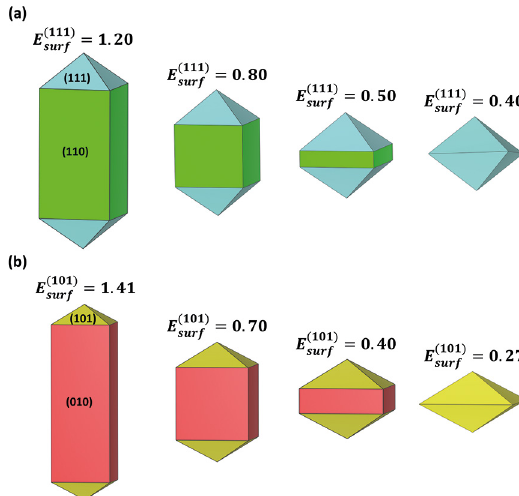
Figure 3. (a) Morphology route by the (111) surface stabilization. (b) Morphology route by the (101) surface stabilization. Surface energy in Jm -2 .